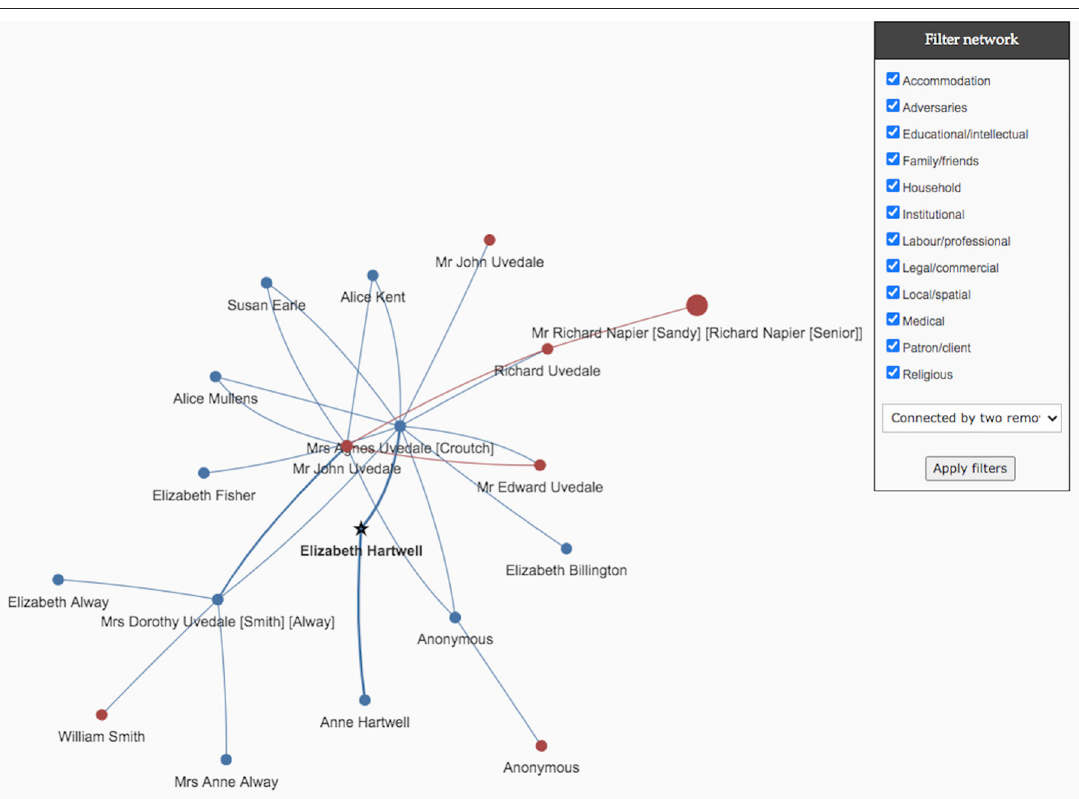
Figure 9: Elizabeth Hartwell’s social network. Lauren Kassell, Michael Hawkins, Robert Ralley,